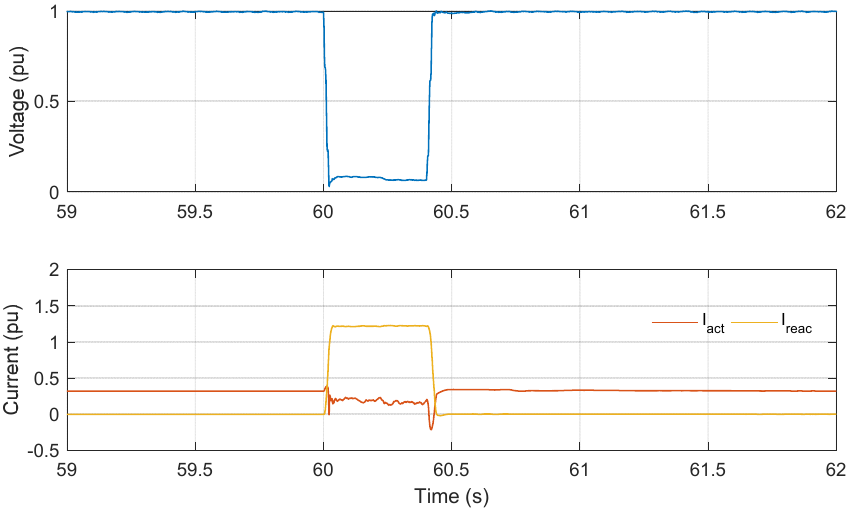
Figure 13. Voltage and currents during UVRT on the low-voltage side.